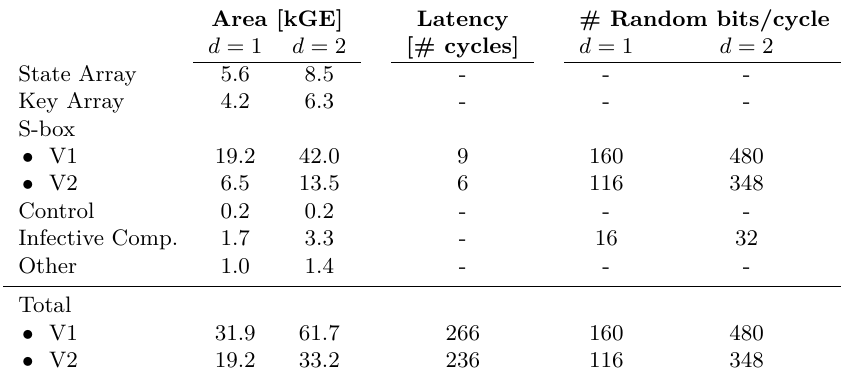
Table 2: Cost of first- and second-order AES implementations Area